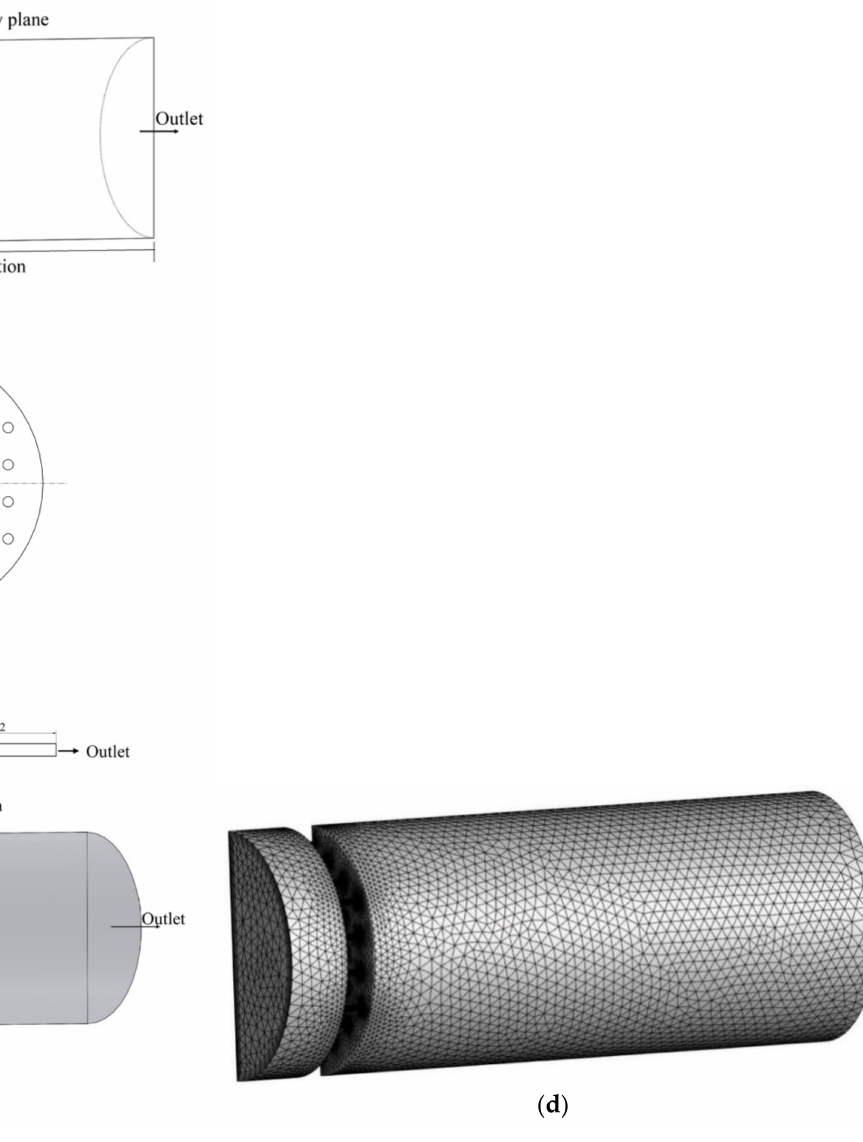
Figure 4. Computational domain and meshing. ( a ) Schematic of the fluid domain of conventional orifice plate structure. ( b ) The distribution of holes on the plate. ( c ) Schematic of fluid domain of the Tesla-type orifice structure. ( d ) Mesh division of Tesla-type orifice